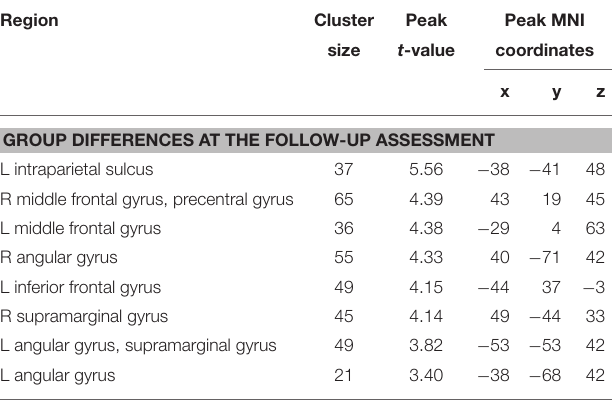
TABLE 5 | Brain areas that showed significant activation for the contrast dyscalculic vs. typically developing children at the follow-up assessment ( p < 0.001, k ≥ 19, cluster-extend corrected).